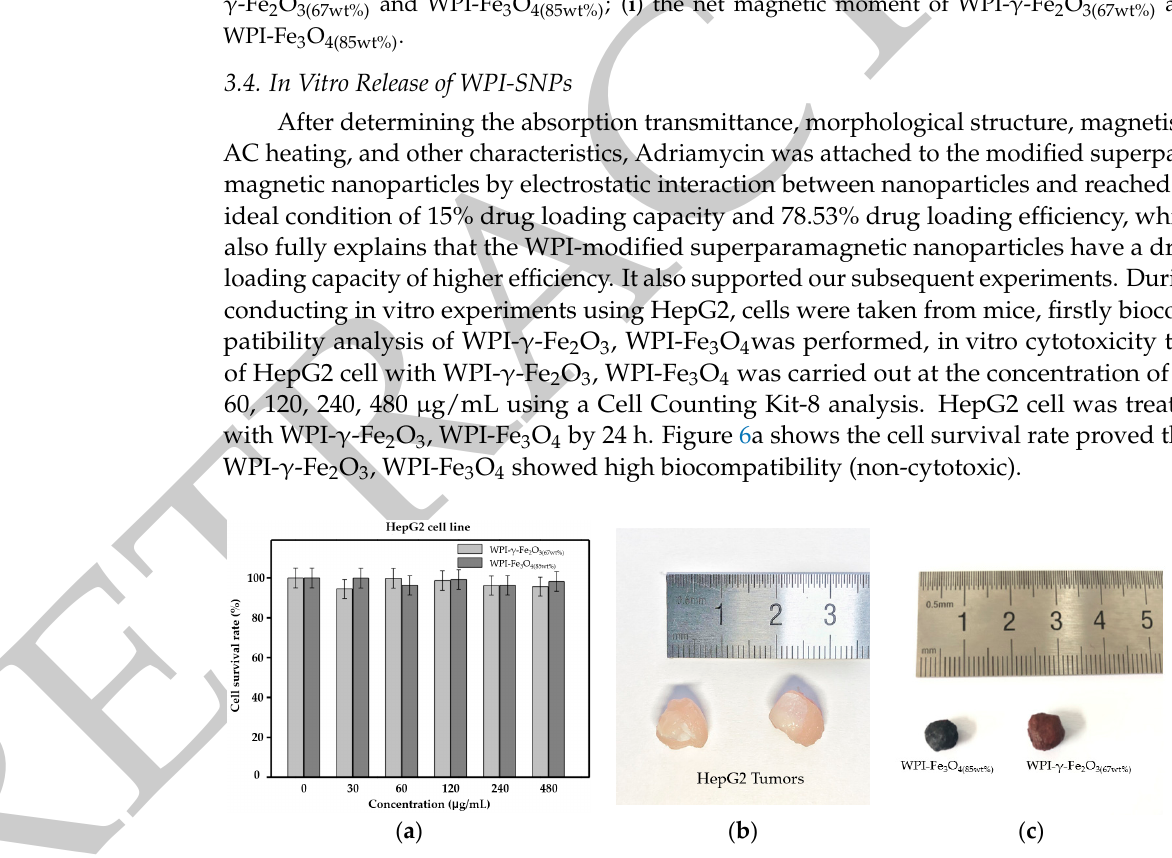
Figure 6. In vitro release of WPI-SNPs: ( a ) cells survival rate results of WPI- γ -Fe 2 O 3(67wt%) and WPI-Fe 3 O 4(85wt%) with HepG2 cell line; ( b ) HepG2 tumors were taken from mice for in vitro experiments; ( c ) HepG2 tumor after in vitro magnetic hyperthermia with WPI- γ -Fe 2 O 3(67wt%) and WPI-Fe 3 O 4(85wt%) .